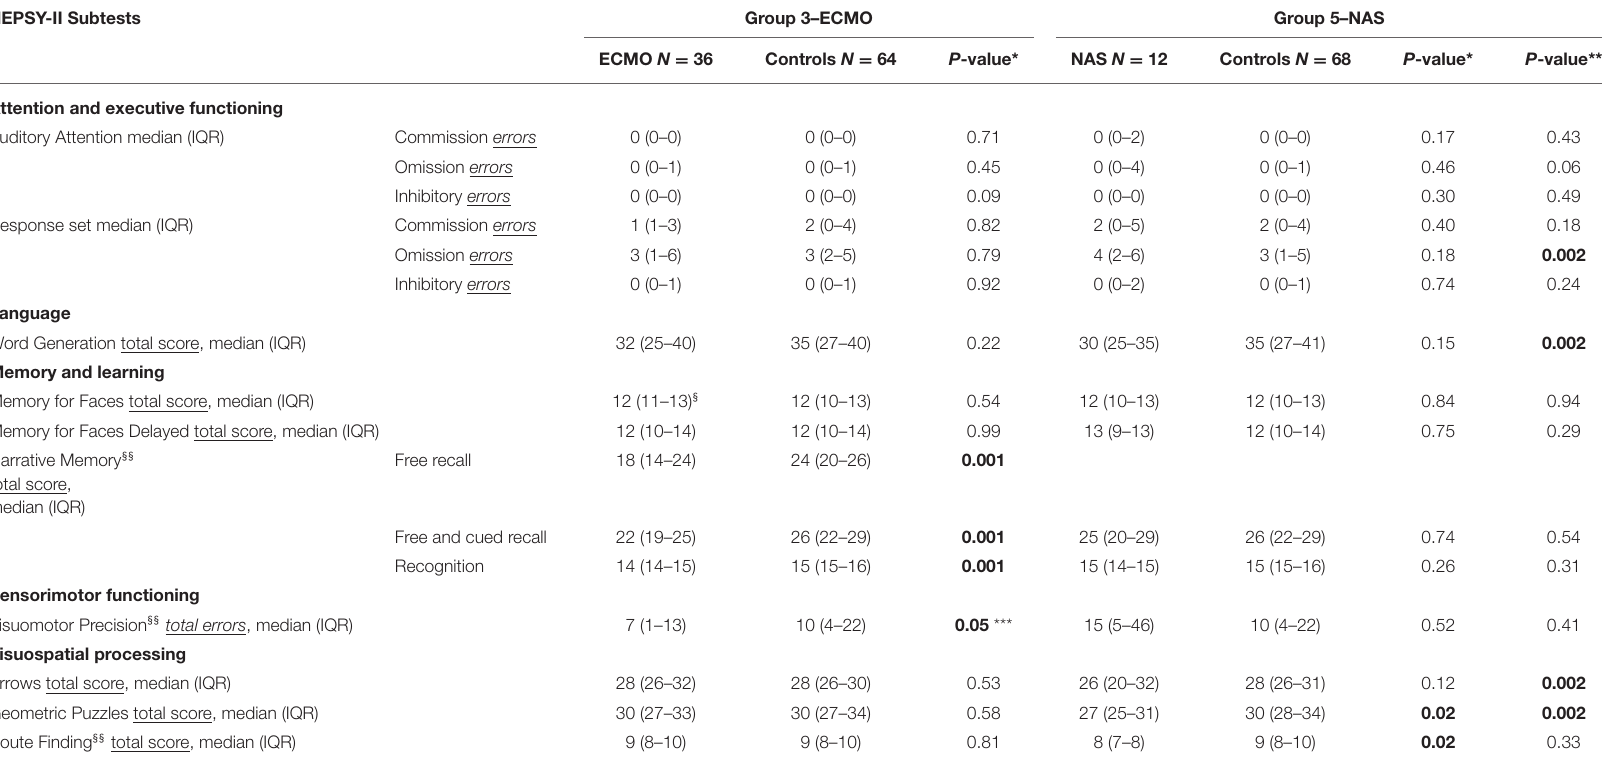
TABLE 4 | Neuropsychological